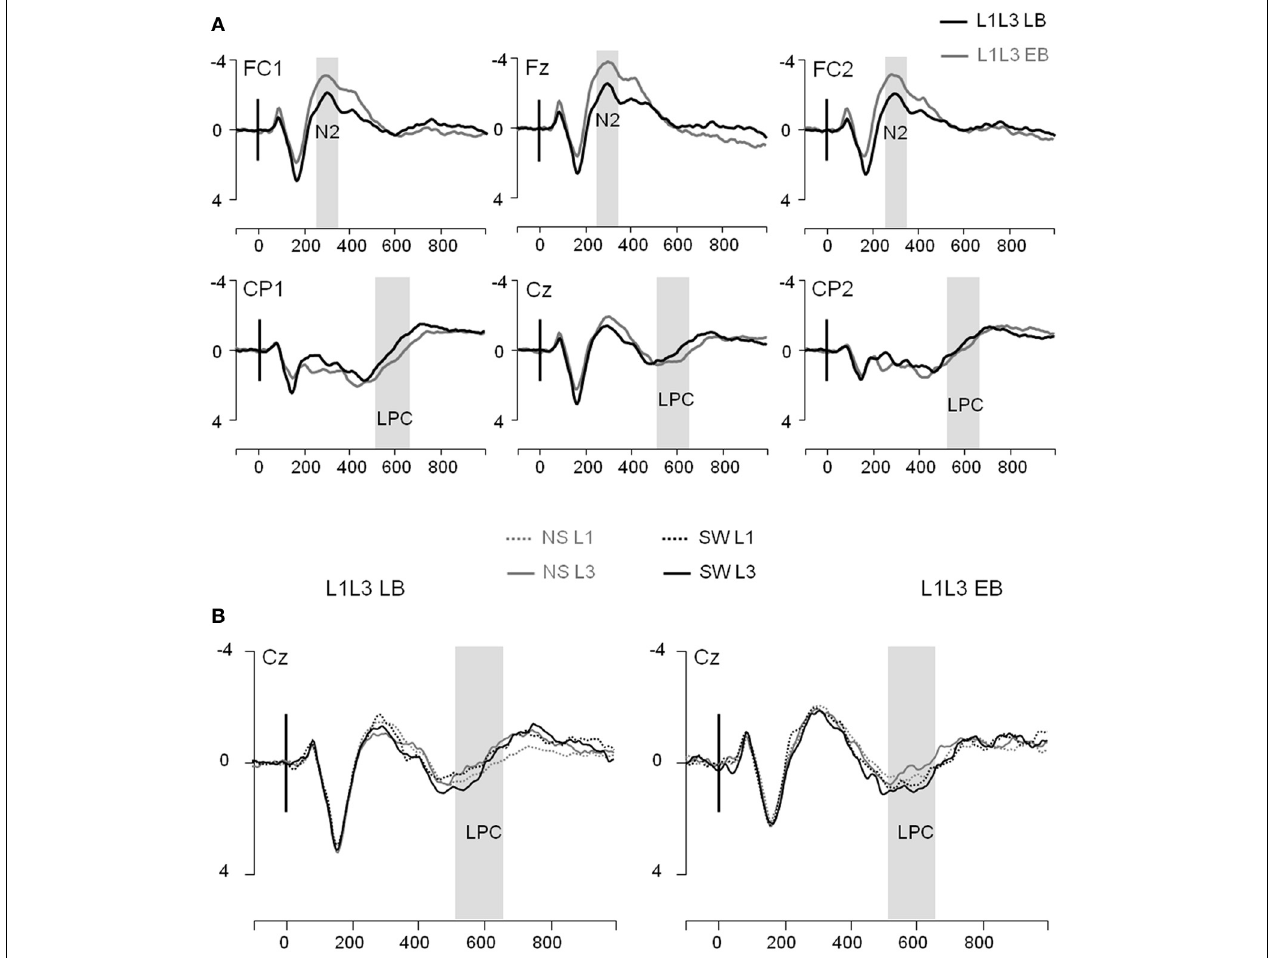
FIGURE 3 | Event-related potentials (Y axis: Mean amplitude in µ V) from the trial presentation (time 0) to 1000ms. (A) ERPs elicited by the presentation of a picture, for L1L3 LB group (black waves) and L1L3 EB group (dark gray waves) at 6 midline electrodes (FC1, Fz, FC2, CP1, Cz, CP2).